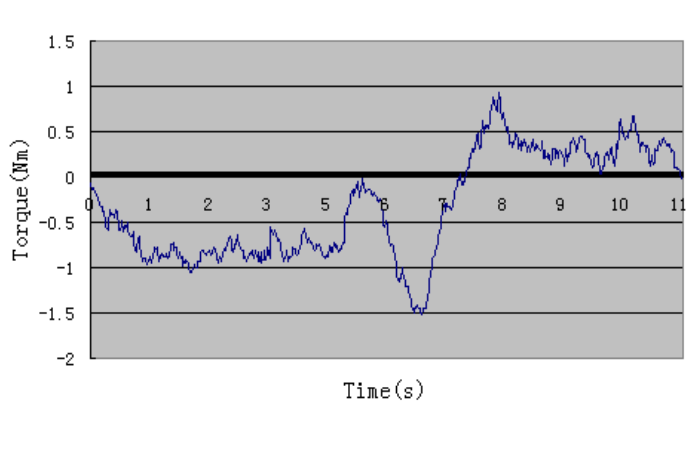
Figure 14. Output torque of